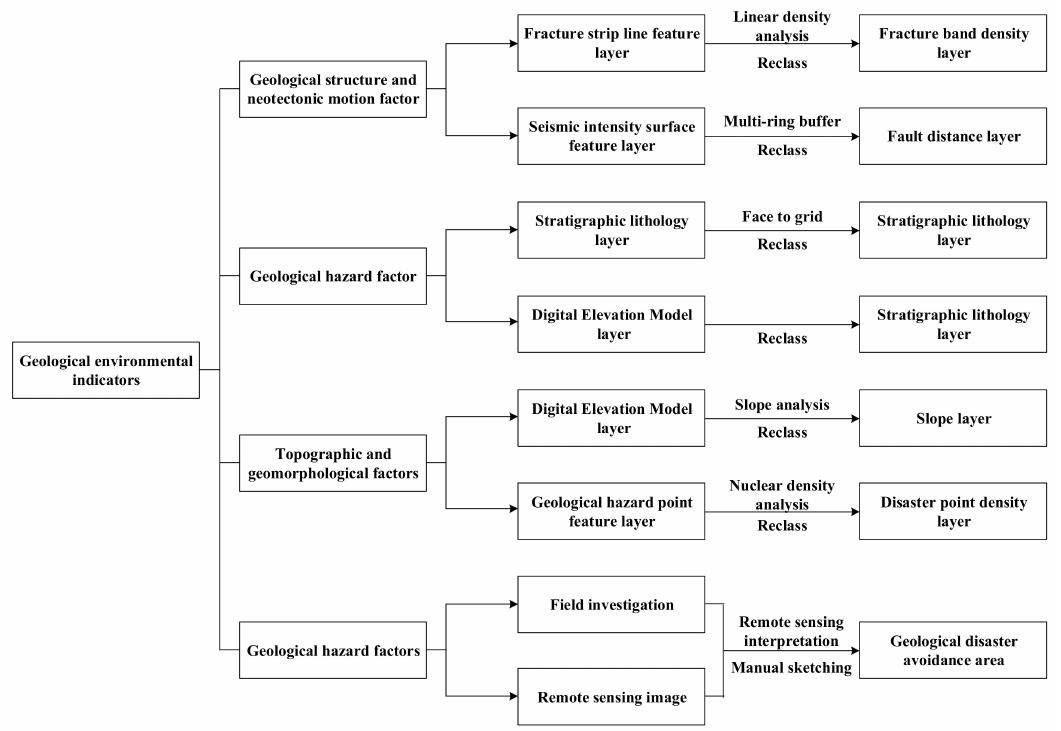
Figure 3. Processing flow chart of geological environment indicators.